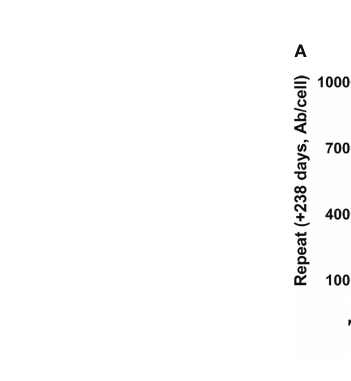
FIGURE 3 | Monocytic HLA-DR density shows stability over time. mHLA-DRd was calculated at enrolment and repeated a mean of 238 (A) and 385 (B) days later. Spearman ’ s test was used to assess goodness-of- fi t (r 2 ) and signi